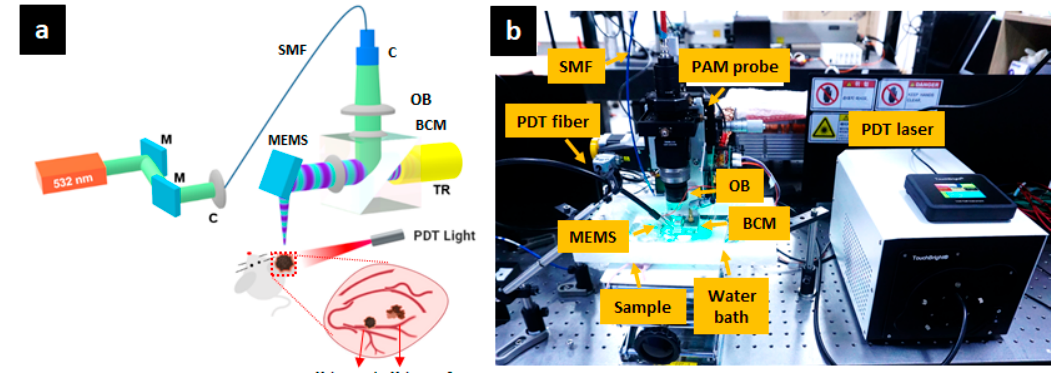
Figure 1. Photodynamic therapy (PDT) monitoring of melanoma tumors in a mouse ear using optical-resolution photoacoustic microscopy (OR-PAM). ( a ) Experimental setup of OR-PAM for monitoring PDT process, ( b ) photograph of the experimental setup. M, mirror; C, collimator; OB, objective lens; BCM, beam combiner; SMF, single-mode fiber; TR, transducer.